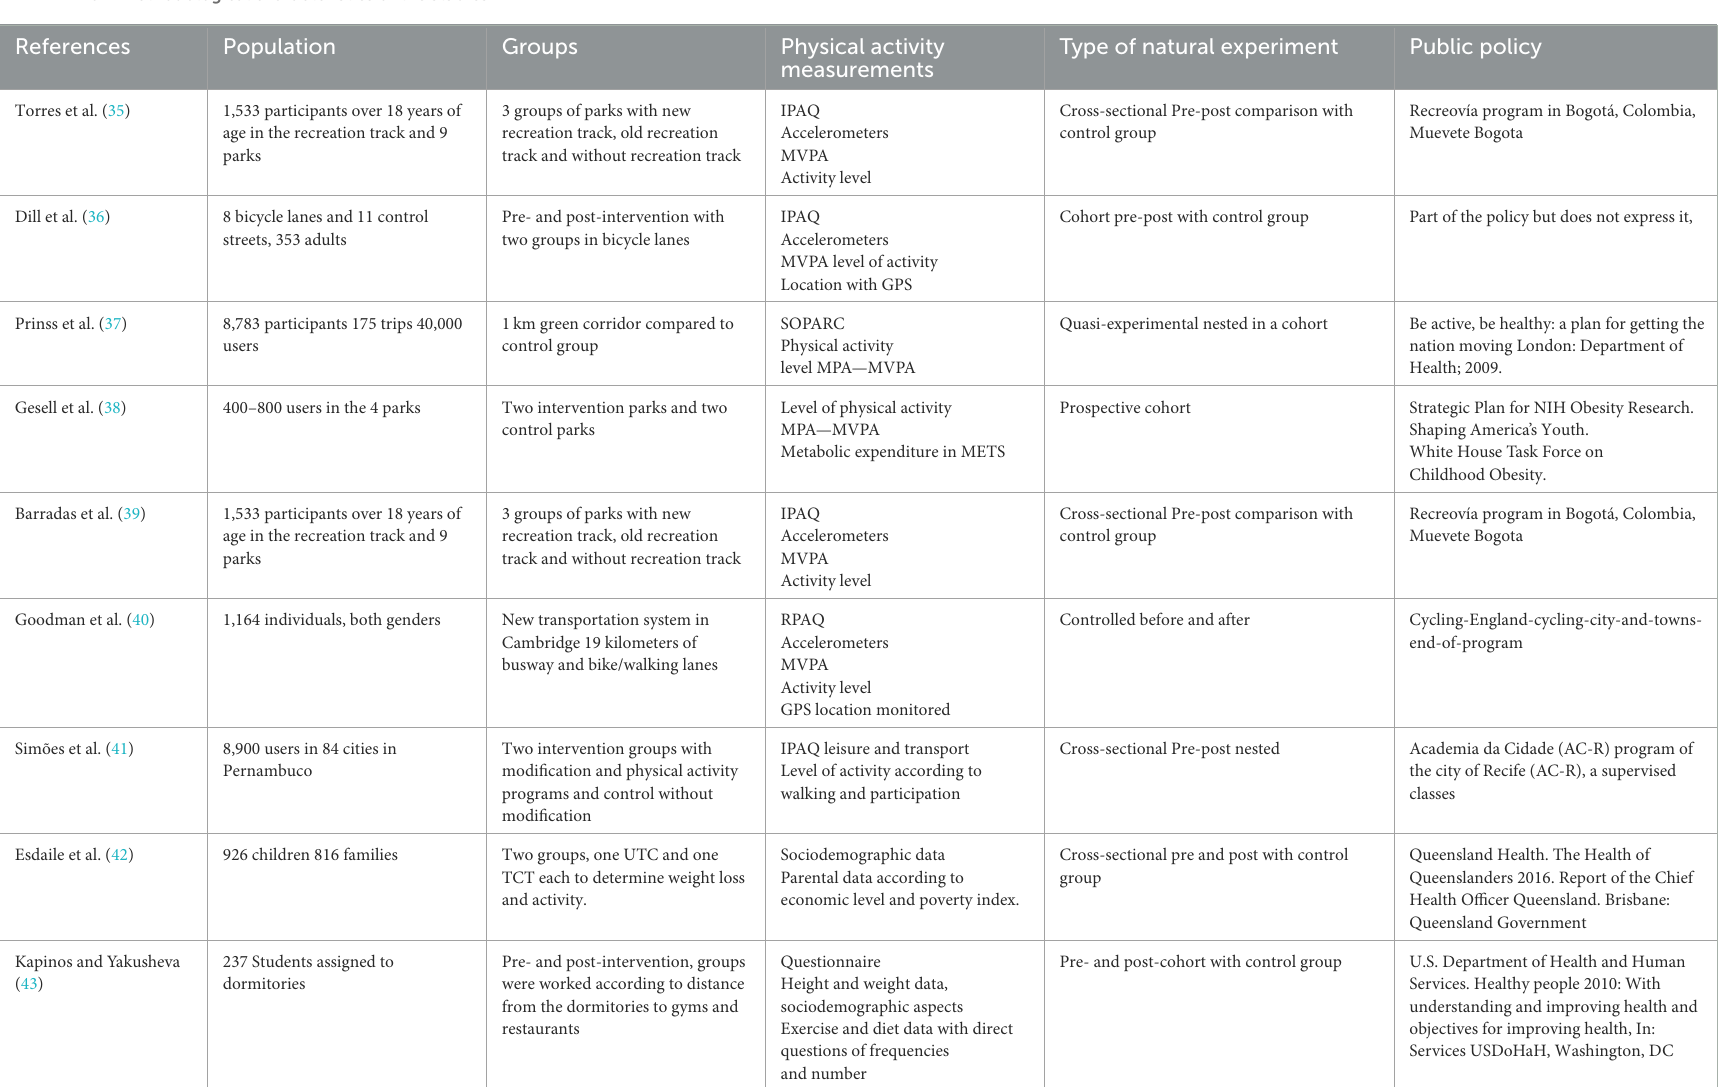
TABLE 2 Main methodological characteristics of the